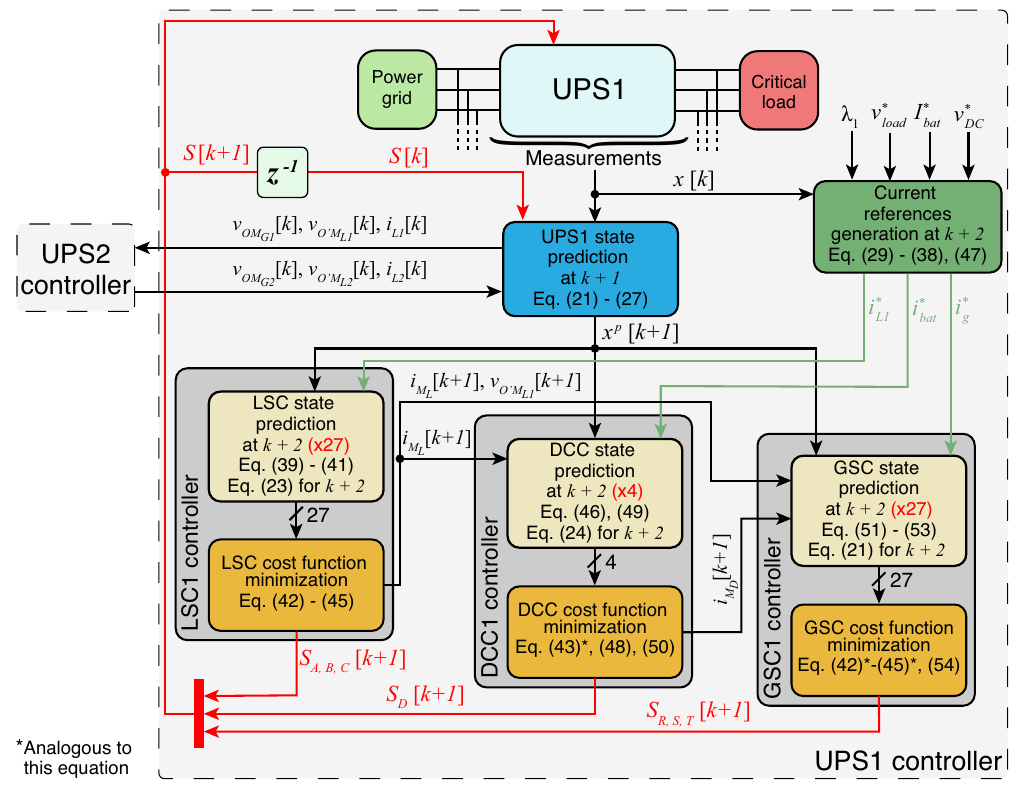
Figure 4. Schematic representation of the proposed UPS controller